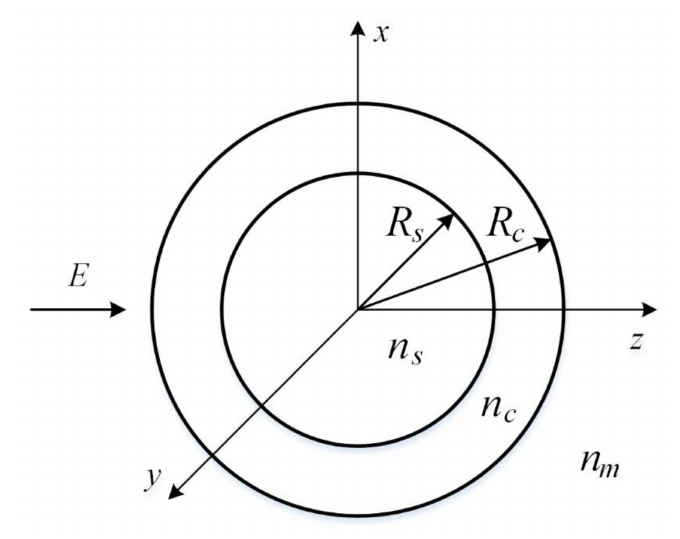
Figure 2. Model of a coated